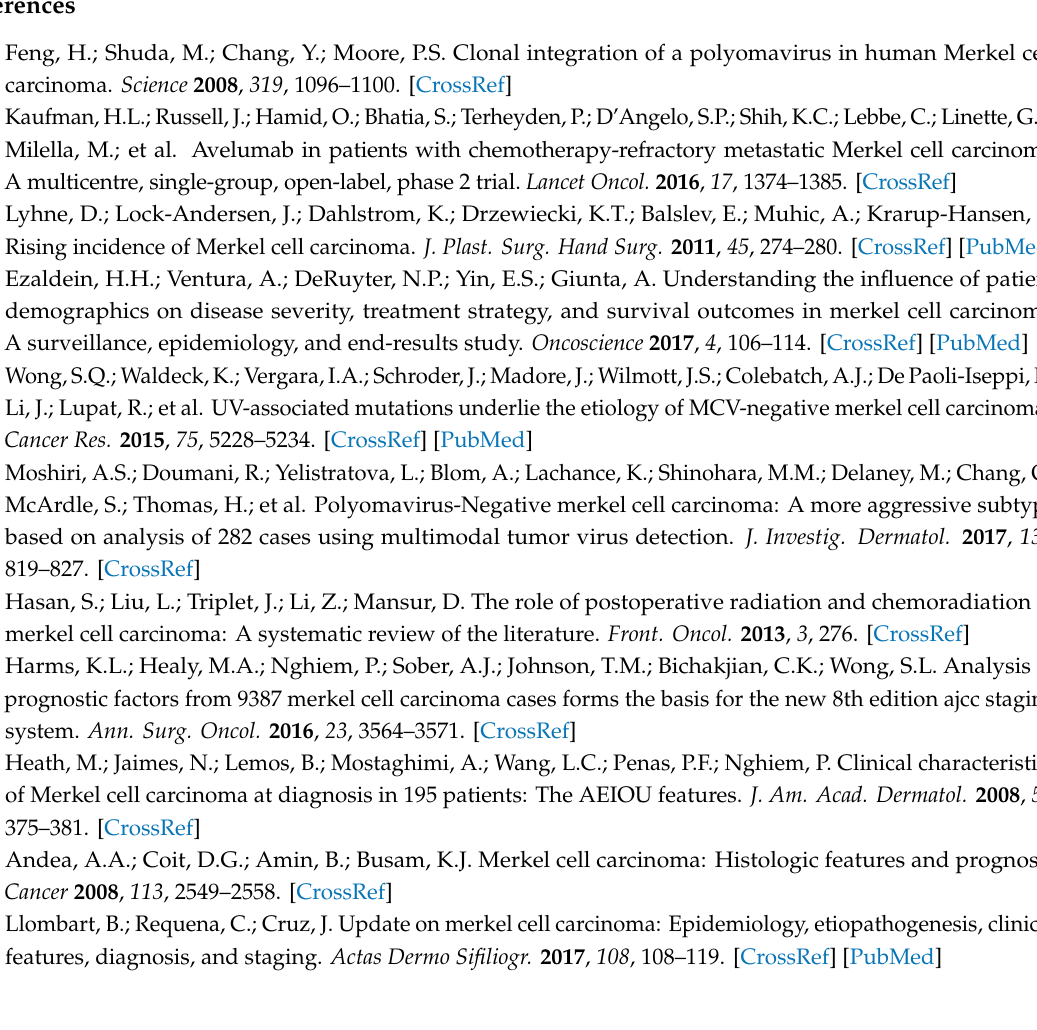
Figure S1: The 8th edition UICC staging system, Figure S2: Treatment algorithm for MCC, Figure S3: Radiotherapy indication and doses for patients with